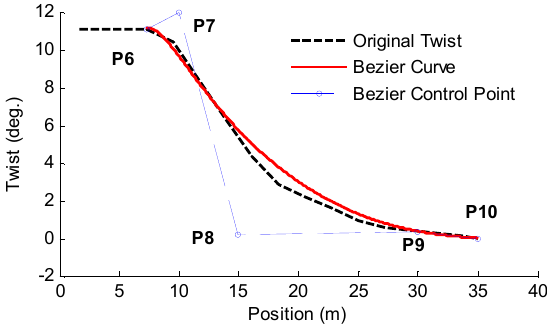
Figure 6. Bezier fitting curve and its control points for the original twist angle.